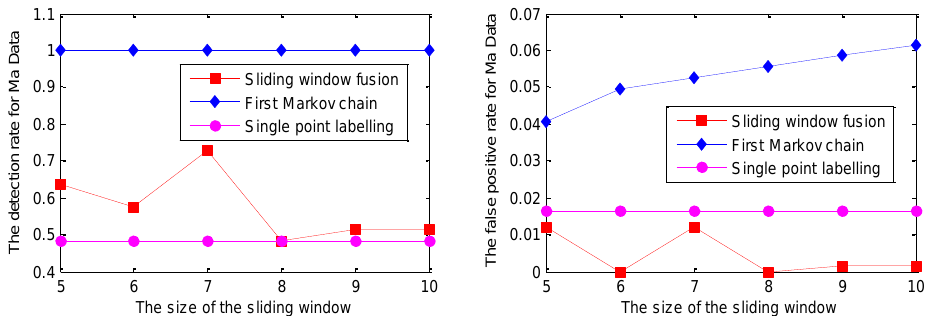
Figure 10. The detection results for Ma Data with the GPR model under different sliding window sizes.